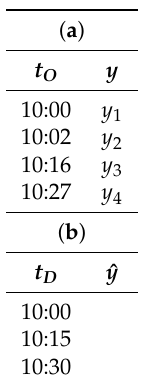
Table 1. Problem definition. ( a ) Captured data. ( b ) Desired temporal reference